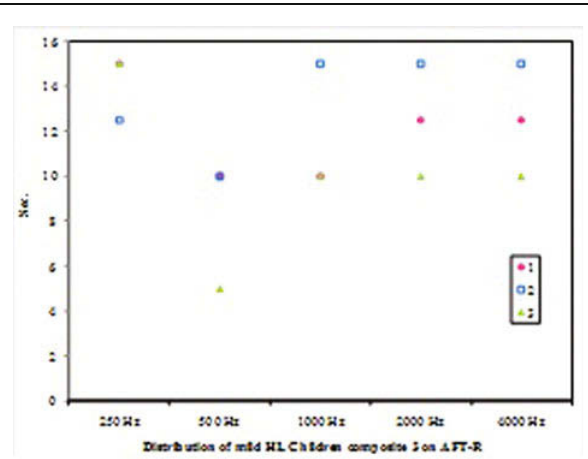
Distribution of the three children with mild HL who have composite score 3 on AFT-R.